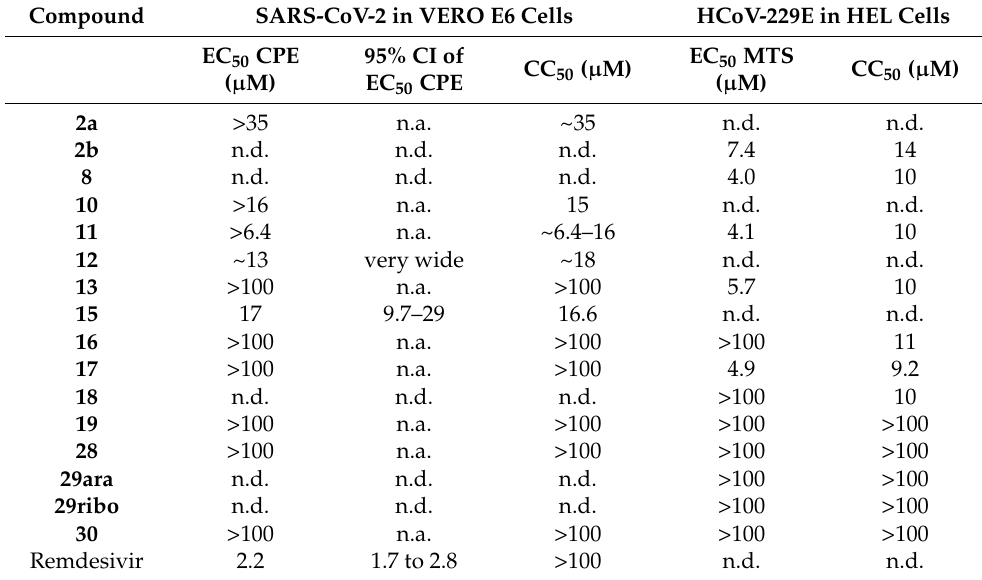
Table 6. In vitro inhibitory activity on coronavirus replication.